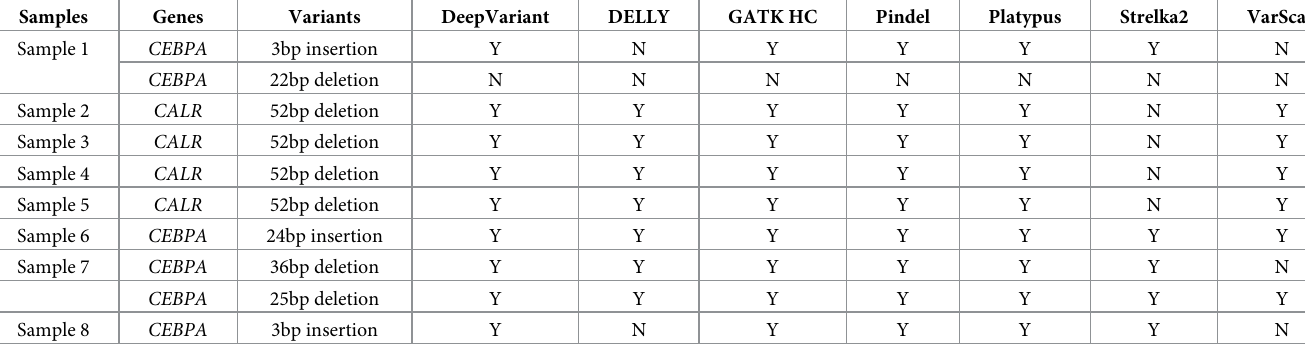
Table 3. Indel calling results for the selected tools with targeted gene panel sequencing dataset of leukaemia patients. Samples Genes Variants DeepVariant DELLY GATK HC Pindel Platypus Strelka2 VarScan Sample 1 CEBPA 3bp insertion Y N Y Y Y Y N CEBPA 22bp deletion N N N N N N N Sample 2 CALR 52bp deletion Y Y Y Y Y N Y Sample 3 CALR 52bp deletion Y Y Y Y Y N Y Sample 4 CALR 52bp deletion Sample 5 CALR 52bp deletion N Y Sample 6 CEBPA 24bp insertion Y Y Y Y Y Y Y Sample 7 CEBPA 36bp deletion Y Y Y Y Y Y N CEBPA 25bp deletion Y Y Y Y Y Y Y Sample 8 CEBPA 3bp insertion Y N Y Y Y Y N For each sample there are one or more indel varying from 3bp to 52bp either in CEBPA or CALR . We manually evaluated the variant calling tools’ results with our truth set. A successful call is marked with "Y", a failed call is marked with "N".